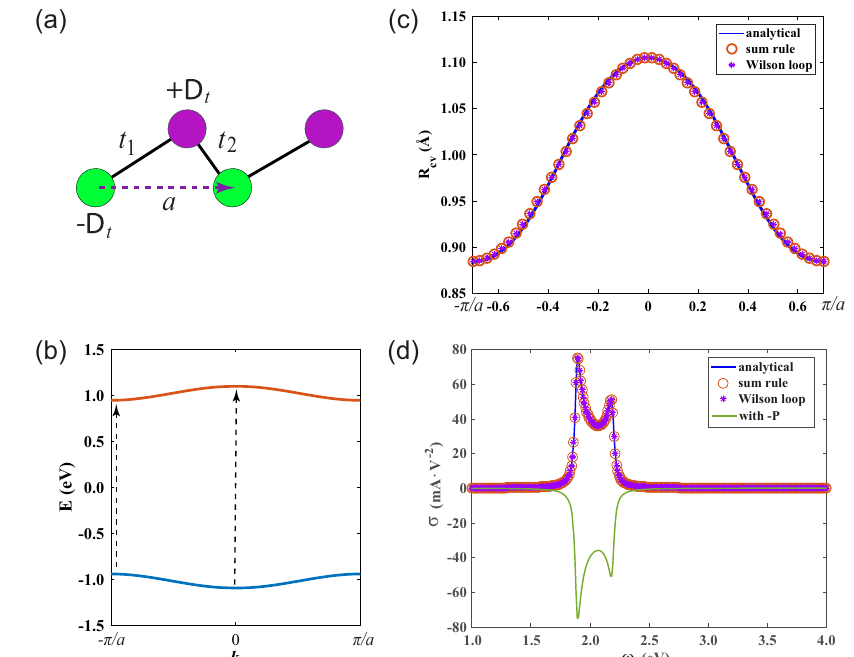
Fig. 2 Band structure, shift current, and shift vector for noncentrosymmetric Rice-Mele model. a Two-band Rice-Mele tight-binding model of one-dimensional polarized chain with two sites in each unit cell. b Energy dispersion of the conduction and valence bands. The arrows denote the optical transition in the edge and center of the fi rst Brillouin zone. c Shift vector calculated by three different methods, including the analytical solution, the sum rule with the mass term, and the Wilson loop approach. d Shift current calculated by the analytical method, the sum rule with the mass term, and the Wilson loop approach. “ -P ” denotes the 1D Rice-Mele model with reversed polarization. The two peaks are related to the optical transitions indicated as two arrows in b